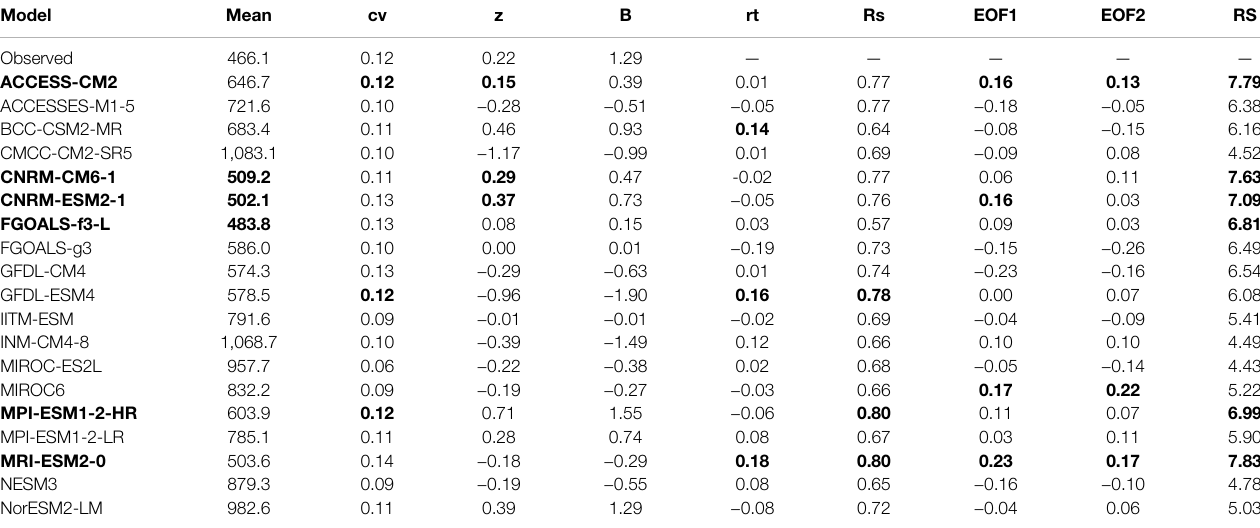
TABLE 3| Statisticalindicesvaluesand RStotal scoresofprecipitation simulatedby19GCMs.Themodelsand indicatorsinbold weretherelativelybetteronesinthetable, and the indicators in bold were performed best in each category. Model Mean cv z B rt Rs EOF1 EOF2 RS Observed 466.1 0.12 ACCESSES-M1-5